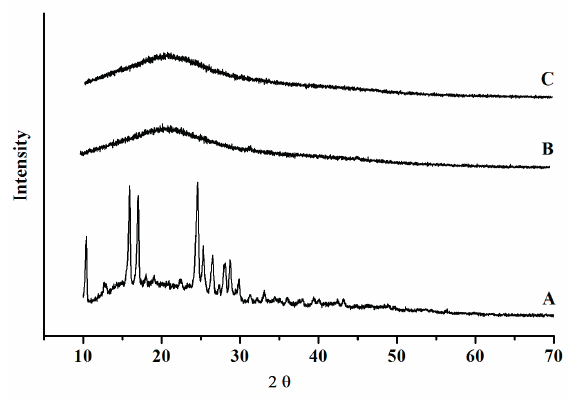
Figure 4. X-ray diffraction patterns of SE ( A ), MP3 ( B ), and MP2 ( C